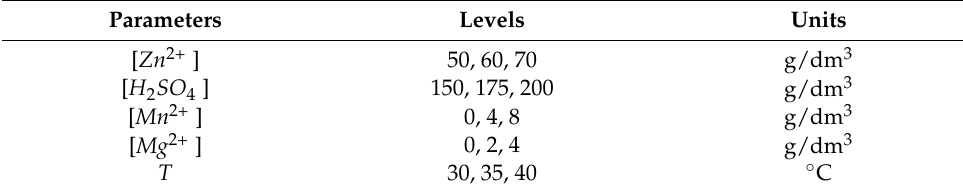
Table 1. Parameters and levels use in this